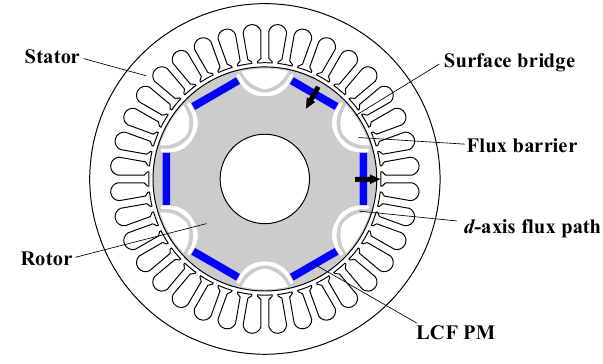
Figure 23. FI ‐ IPM VFM machine [70]. Figure 23. FI-IPM VFM machine